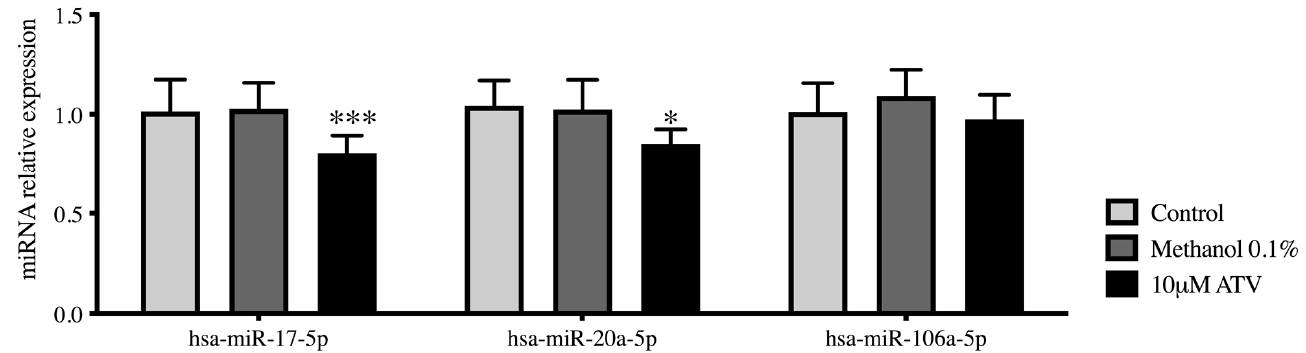
Figure 2. Relative expression of miRNAs in HepG2 cells treated with ATV 10 µ M. Gene expression analysis of miRNAs hsa-miR-17-5p, hsa-miR-20a-5p and hsa-miR-106a-5p in control cells, vehicle- treated cells (methanol 0.1%) and cells treated with 10µM ATV. * p = 0.0456 *** p < 0.0001 by unpaired t-test when compared with vehicle-treated cells (methanol 0.1%). The experiments were performed in technical and biological triplicates. ATV: atorvastatin.